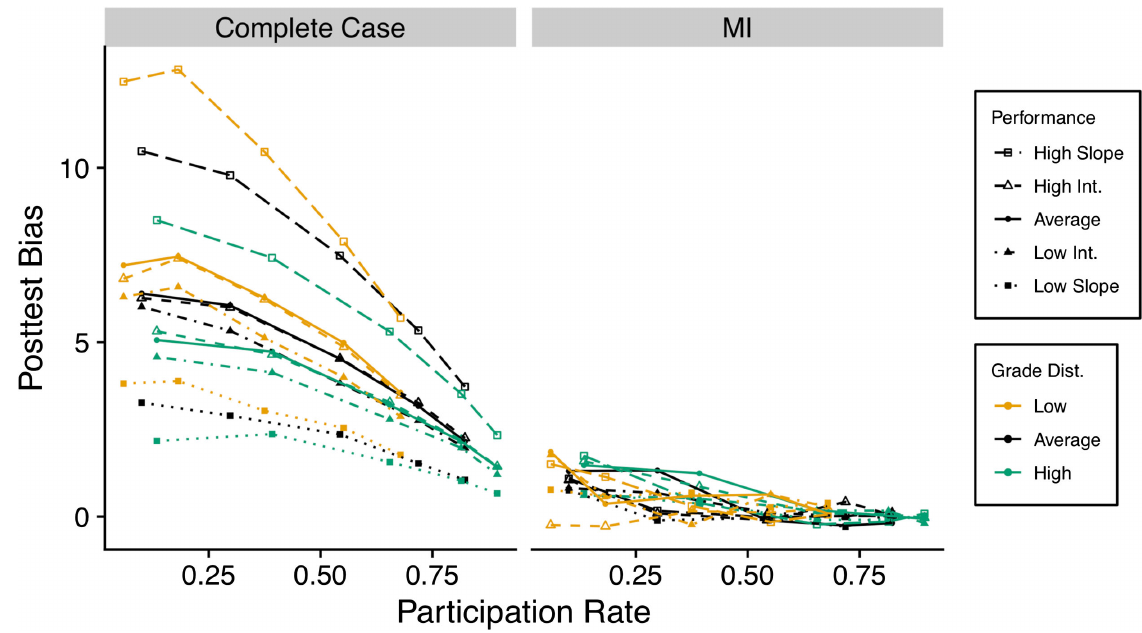
FIG. 10. Bias in the post-test data introduced by complete-case analysis or